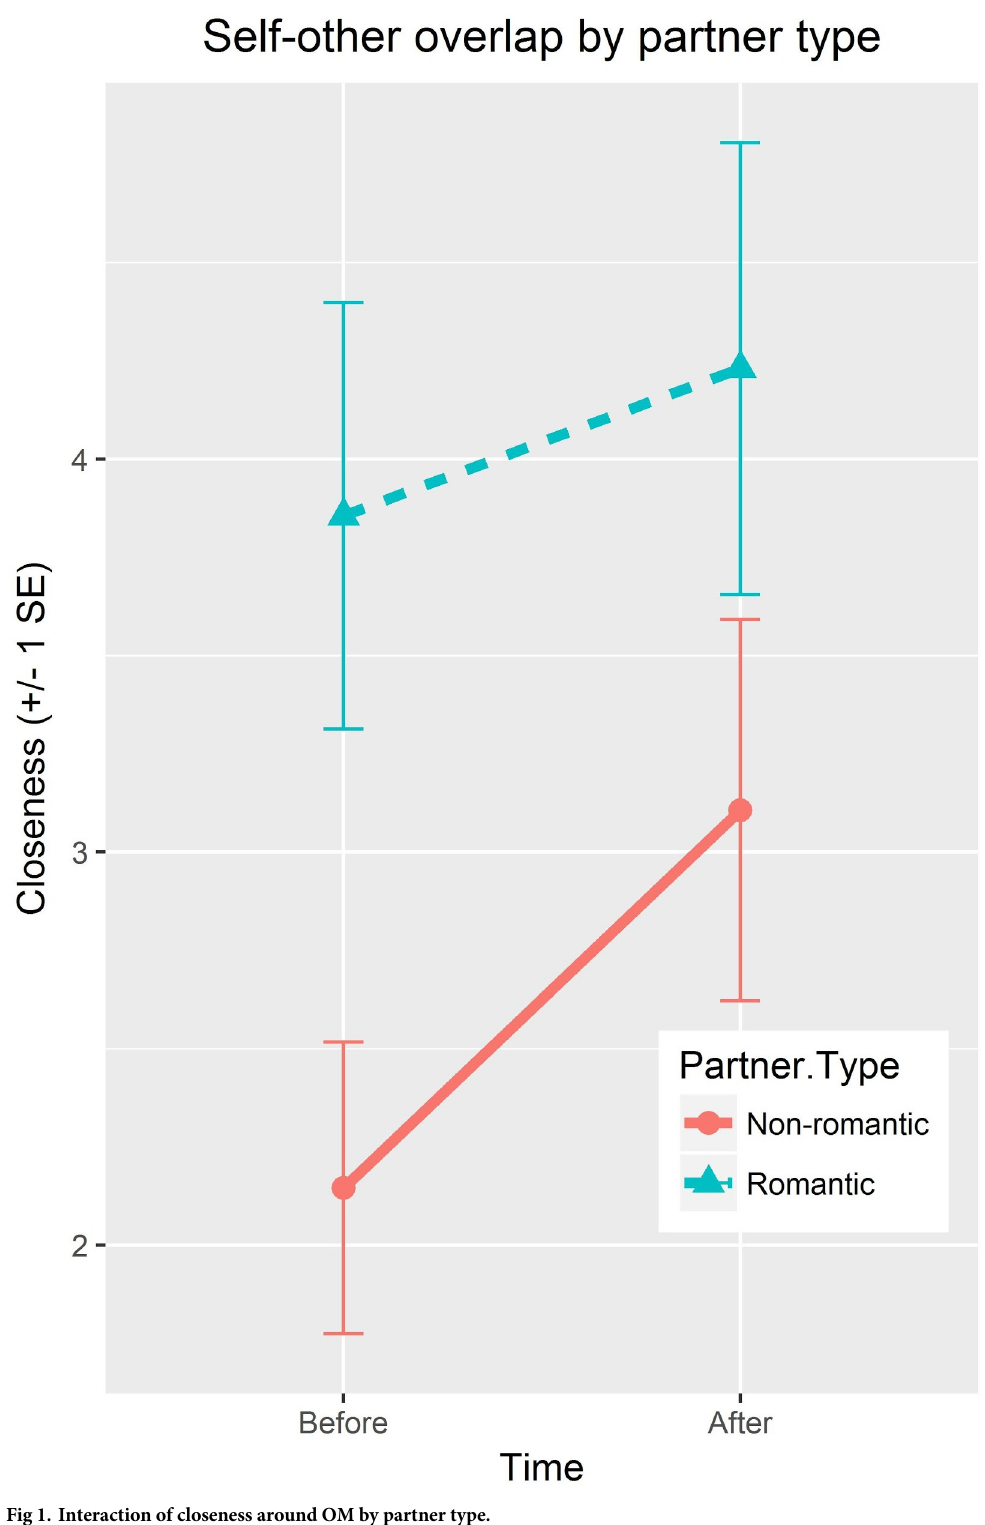
Fig 1. Interaction of closeness around OM by partner type.